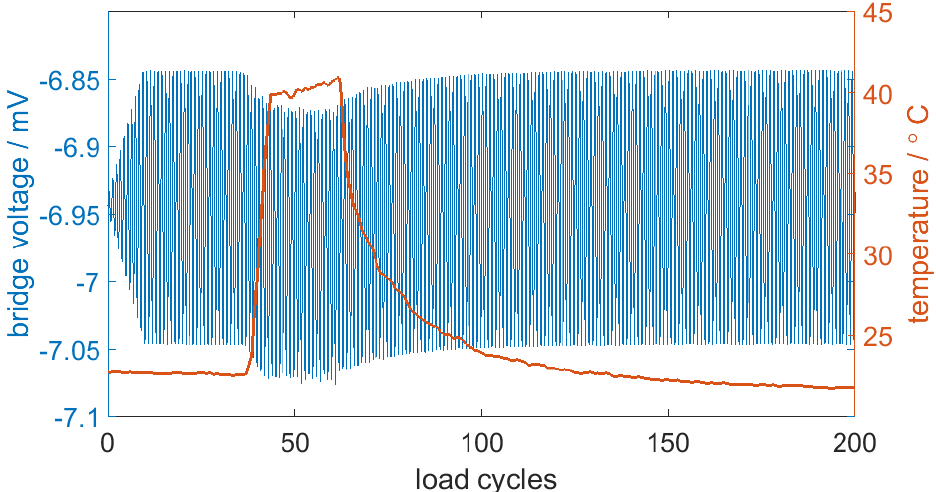
Figure 8. The measured bridge signal with the heat impulse; a 25 °C heat impulse led to a 10% bridge voltage change.